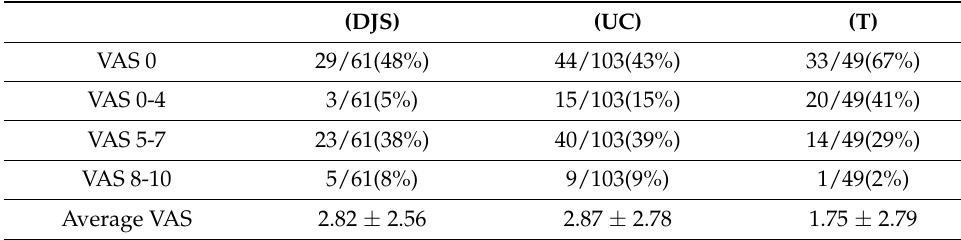
Table 2. Postoperative VAS groups.